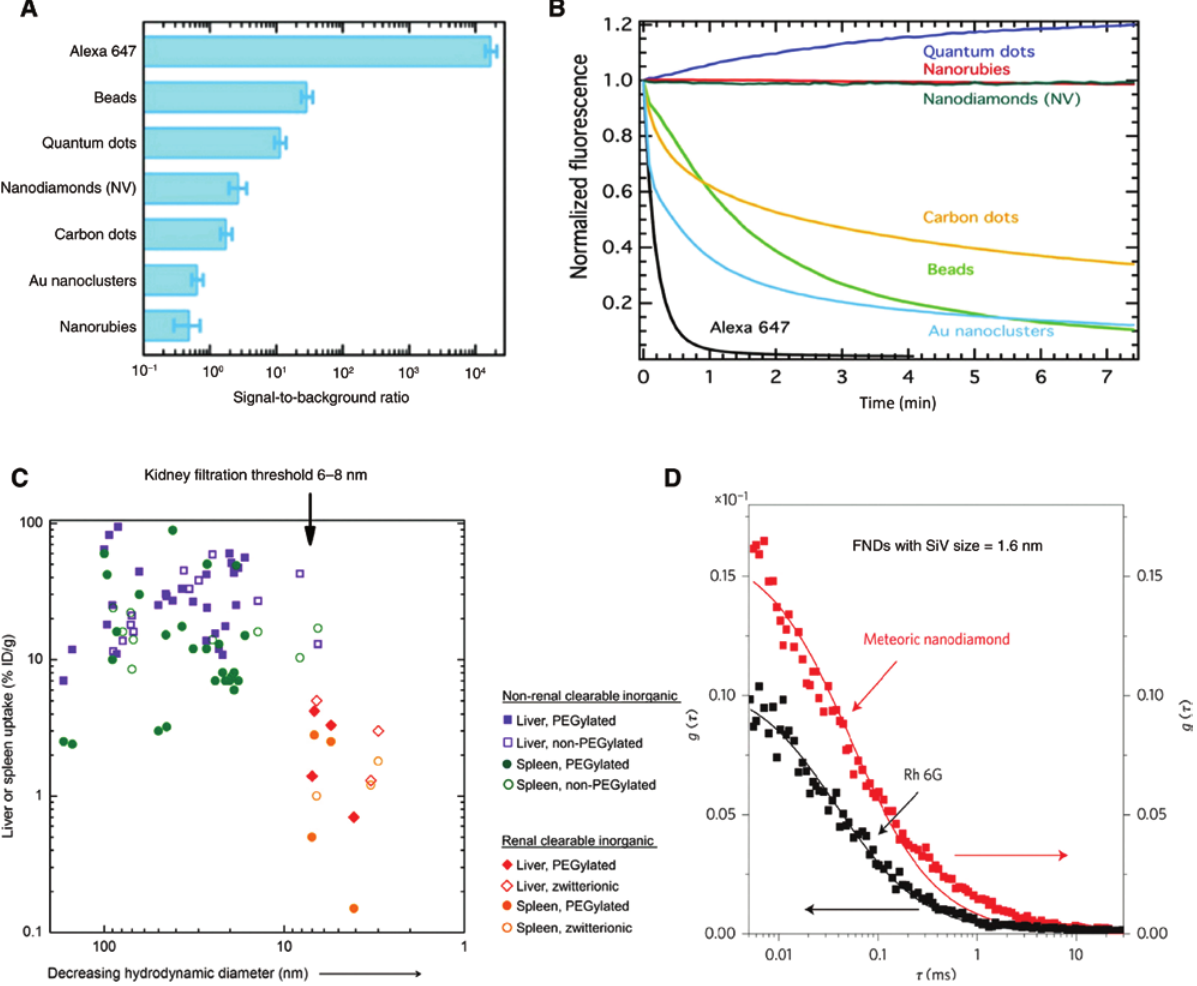
Figure 3: A Brightness and photostability of FNDs compared to other fluorescent nanoparticles. Also a demonstration of kidney filtration threshold of small